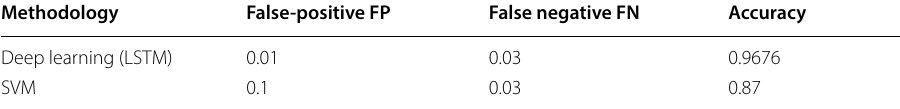
Table 5 Comparing false-positive of Deep vs SVM on NSL-KDD Benchmark